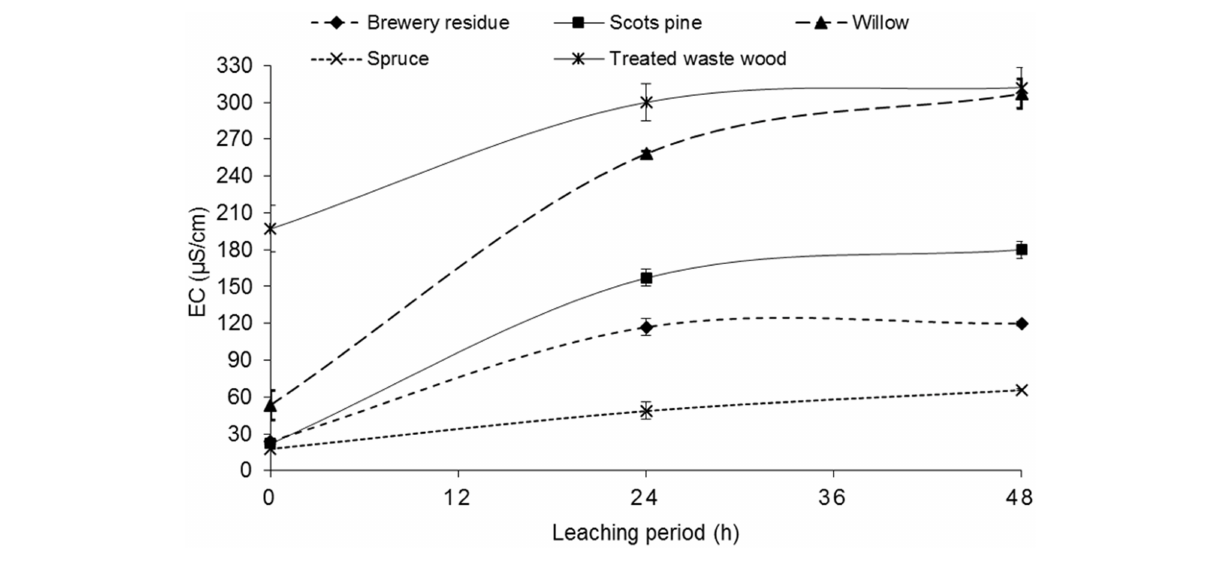
FIGURE 3 | Increase in electrical conductivity (EC) over the 48h leaching